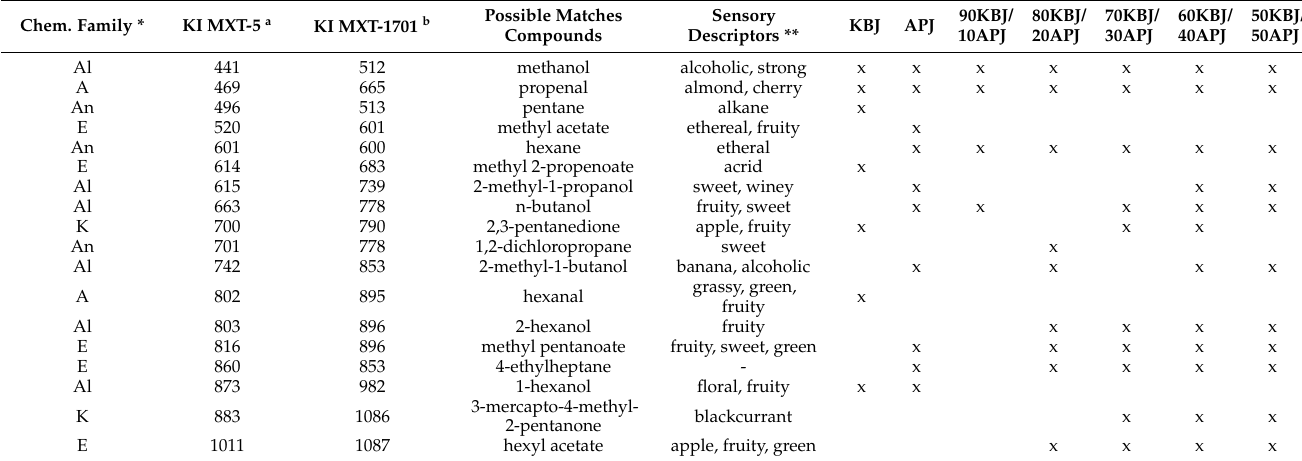
Table 2. Characterization of the main volatile compounds identified in the headspace of kiwiberry and apple juice and their mixes.